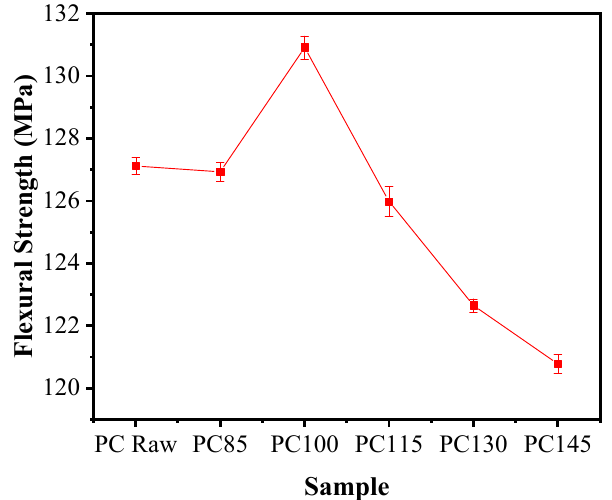
Figure 4. The flexural strength of the GF-PC composites before and after aging.